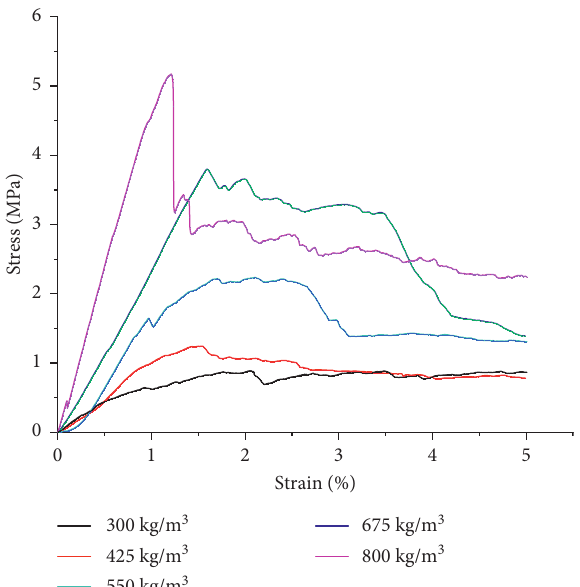
Figure 3: Compression curve model of cast-in-situ foamed